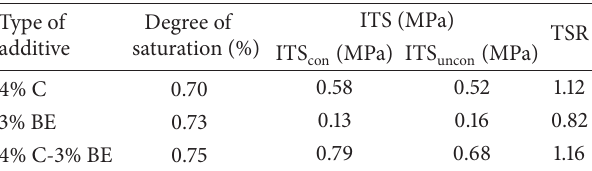
Table 6: Results of TSR of conditioned and unconditioned speci- mens.